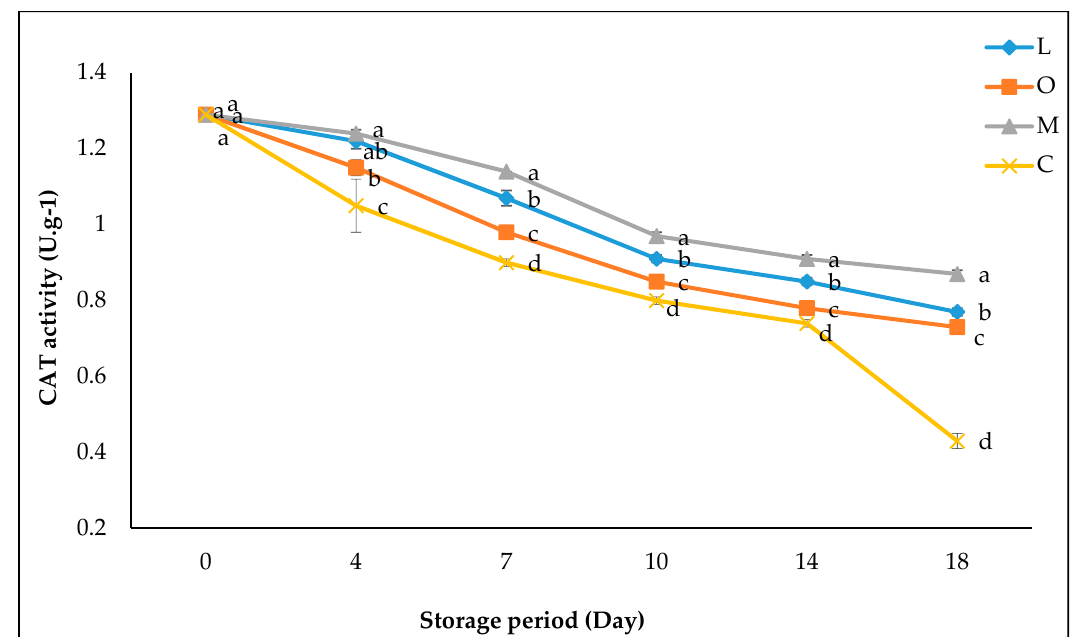
Figure 13. Effect of different essential oil emulsions (L = lemon, O = orange, and M = mandarin Figure 13. E ff ect of di ff erent essential oil emulsions (L = lemon, O = orange, and M = mandarin essential oil) on catalase activity (CAT) of strawberry fruits stored at 2 °C for 18 days. Vertical bars essential oil) on catalase activity (CAT) of strawberry fruits stored at 2 ◦ C for 18 days. Vertical bars indicate the standard deviation (n = 6). Means and different letters indicate significant difference indicate the standard deviation (n = 6). Means and di ff erent letters indicate significant di ff erence between treated and control fruits at each storage period (Duncan’s of 95%). between treated and control fruits at each storage period (Duncan’s of